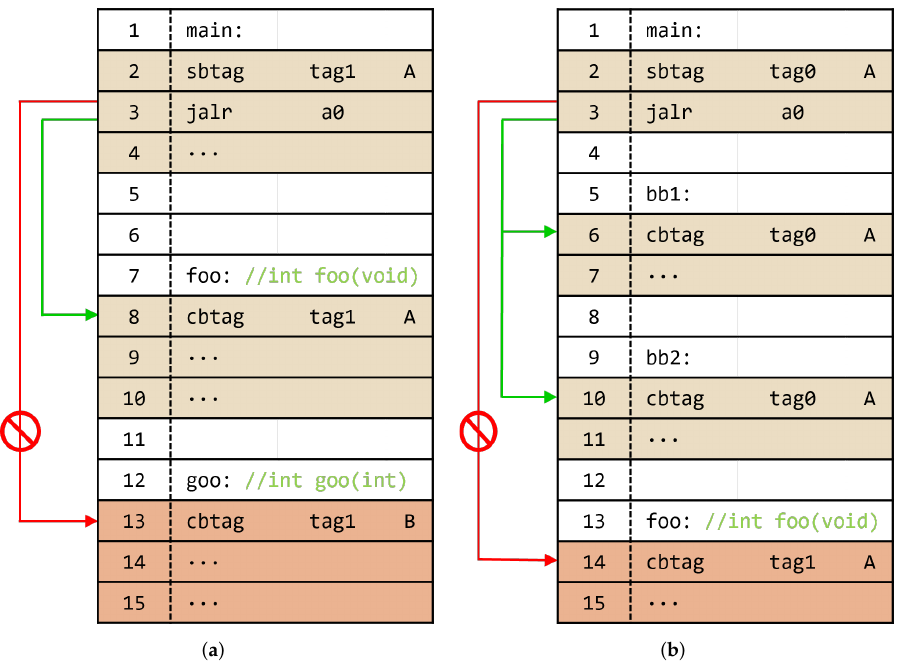
Figure 7. CFI solutions using Bratter : ( a ) indirect call protection; and ( b ) indirect jump